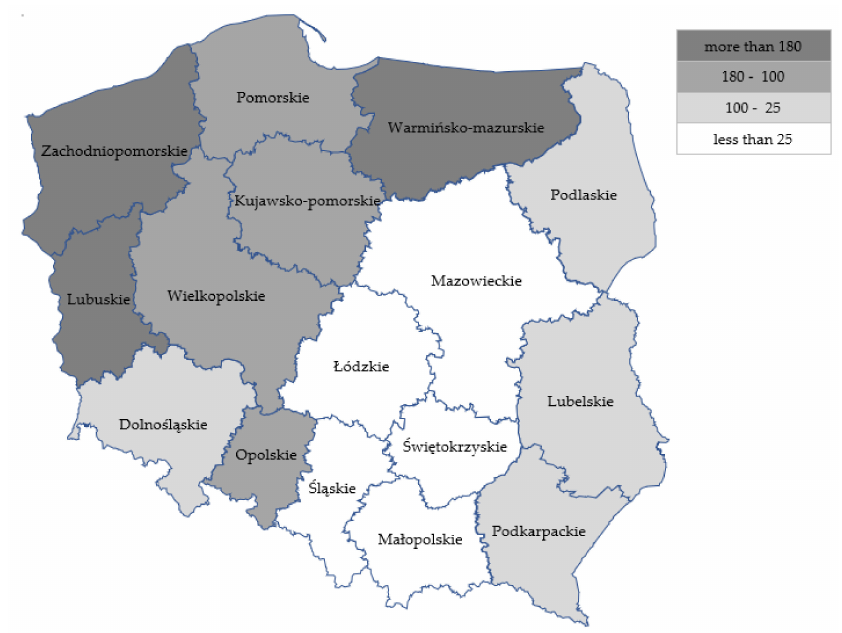
Figure 1. Number of flats sold from state-owned farm resources per 10,000 total population ( W 1 ) in voivodeships. Source: The authors’ calculations based on data of: KOWR and